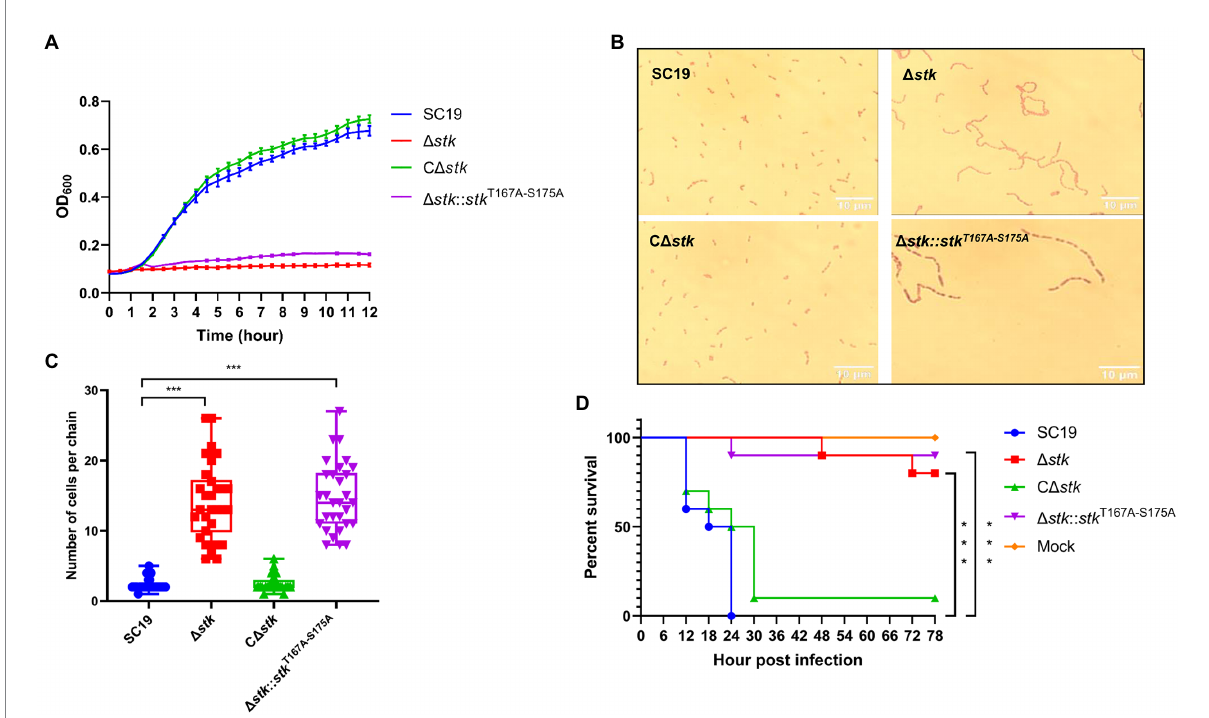
FIGURE 2 The role of autophosphorylation of ssSTK in the morphology, growth, and pathogenicity of Streptococcus suis . (A) Growth assay. Cells of S. suis SC19, Δ stk , C Δ stk , and Δ stk::stk T167A-S175A were grown in the chemically defined medium (CDM) and OD 600 monitored; (B) Gram staining assay. Cells of S. suis SC19, Δ stk , C Δ stk , and Δ stk::stk T167A-S175A were grown to the mid-log phase. Then, the cells were washed twice and resuspended in normal saline. Each sample (20 μ l) was fixed on glass slides and stained. The samples were then observed using an optical microscope. (C) 30 chains were randomly chosen from each Gram staining images of SC19, Δ stk , C Δ stk, and Δ stk :: stk T167A-S175A , respectively. Next, numbers of cells per chain were counted, respectively, and the data were presented as the means ± standard errors ( n = 30). Student’s t -test was used to analyze their chain length difference in GraphPad Prism 7 software, with the value of p < 0.001, ***. (D) G. mellonella larvae infection assay. The G. mellonella larvae were inoculated with 1 × 10 6 CFU of S. suis SC19, Δ stk , C Δ stk , Δ stk::stk T167A-S175A and the same volume saline (Mock). The survival for each group was recorded every 6 h for 78 h. The survival data were analyzed by log − rank test in GraphPad Prism 7 software, with the value of p < 0.001, ***.